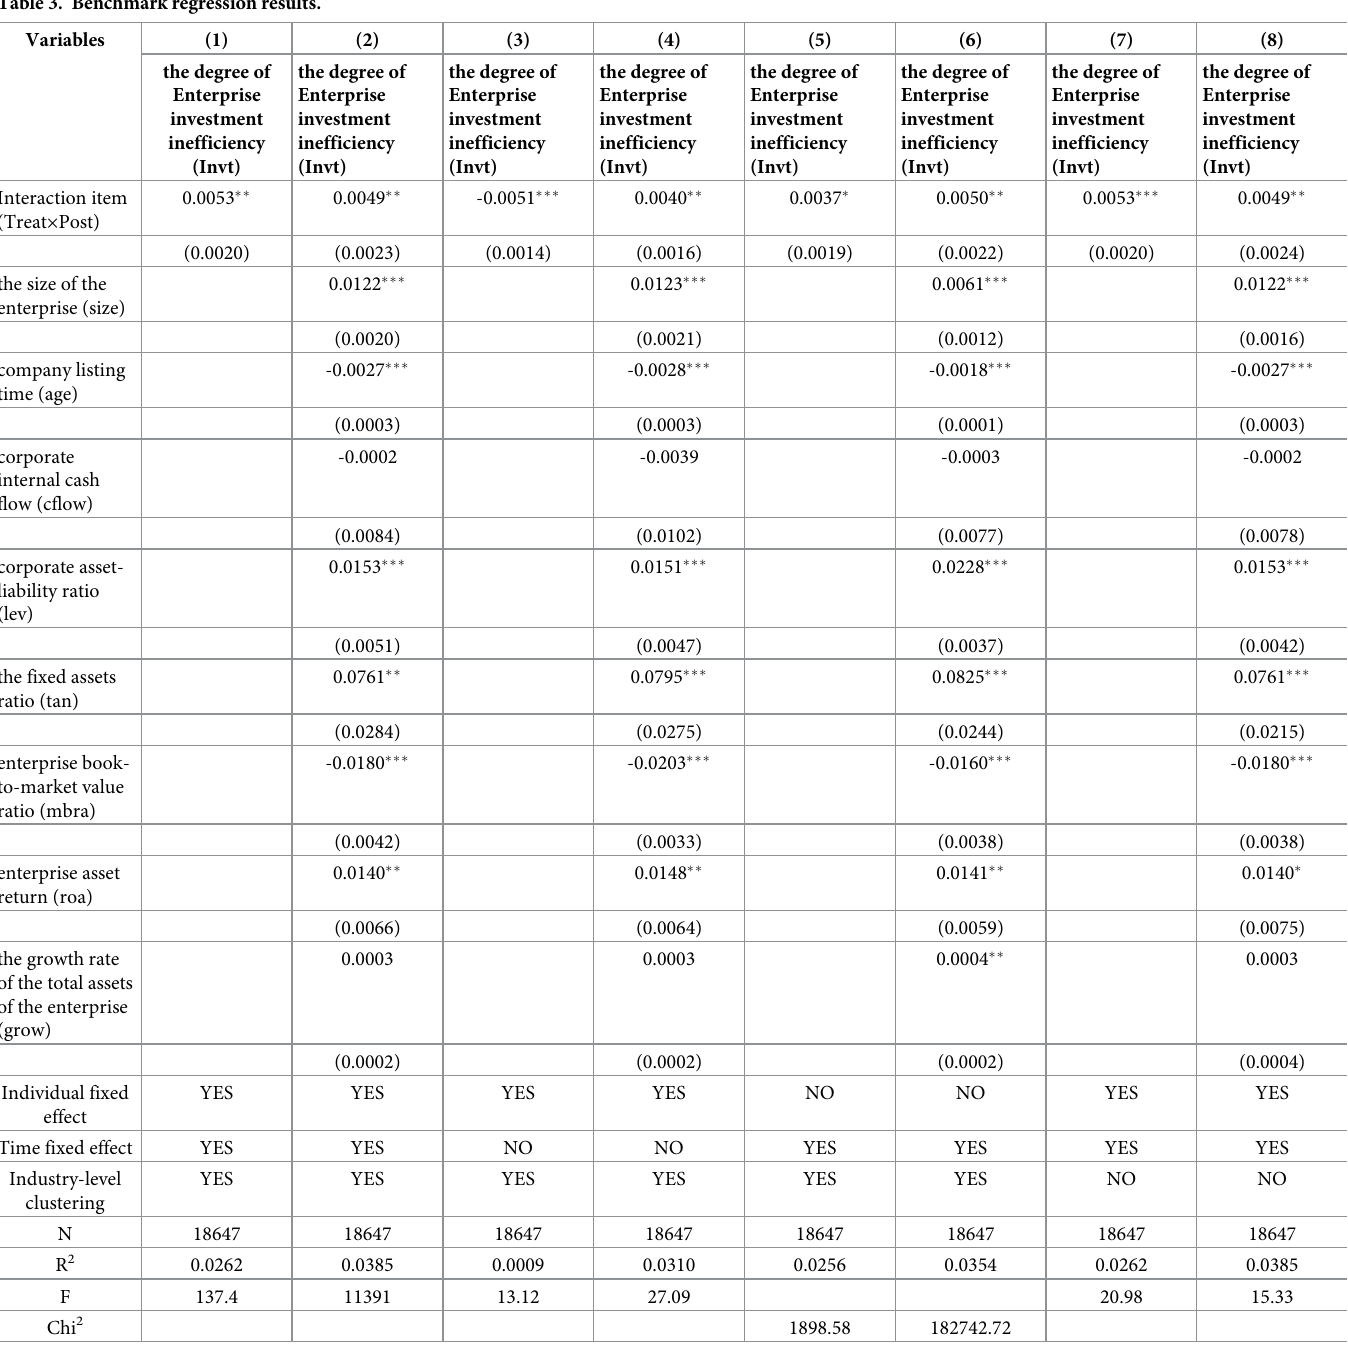
Table 3. Benchmark regression